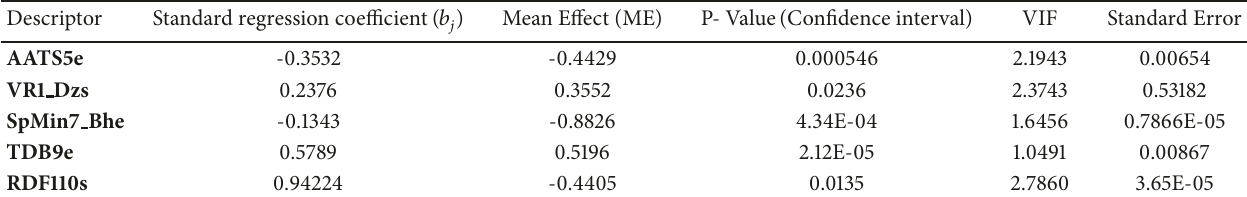
Table 4: Statistical parameters that influence the model.